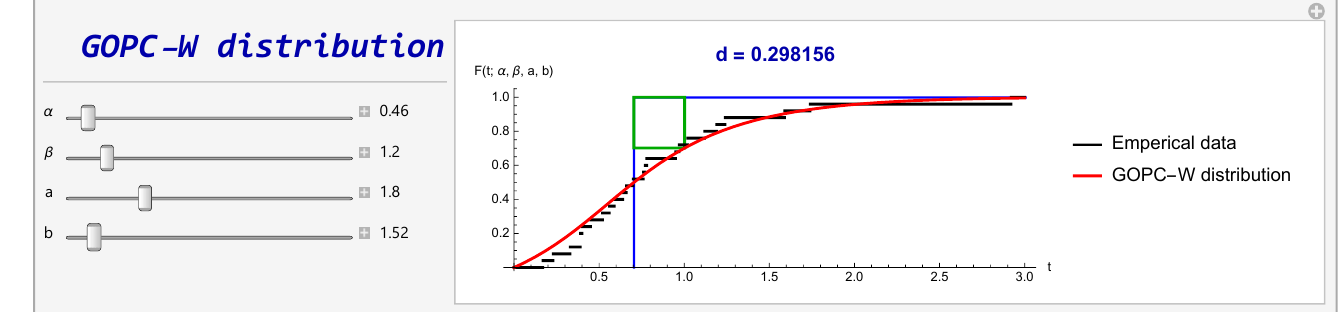
Figure 6. The model (8) for runoff amounts data (normalized) of Jug Bridge,